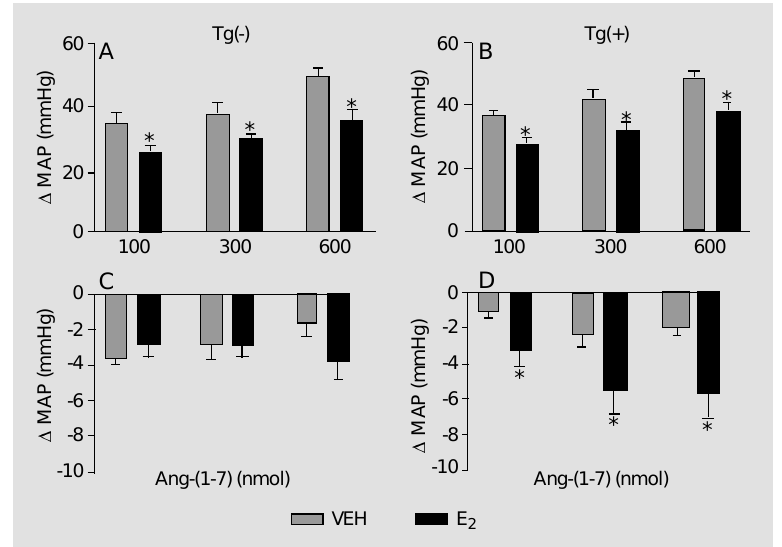
Figure 4 - Effects of 3-week estrogen (E 2 ) replacement on Ang-(1-7) pressor/depressor responses of conscious, resting Tg(-) (A, C) and Tg(+) rats (B, D). E 2 attenuates the Ang-(1- 7)-induced pressor responses of both Tg(-) (A) and Tg(+) (B) animals, but augments the depressor responses of Tg(+) rats (D). Values are reported as mean ± SEM. *P<0.05, VEH vs E 2 (ANOVA). VEH = Vehicle. (Reproduced from Ref. 62 with